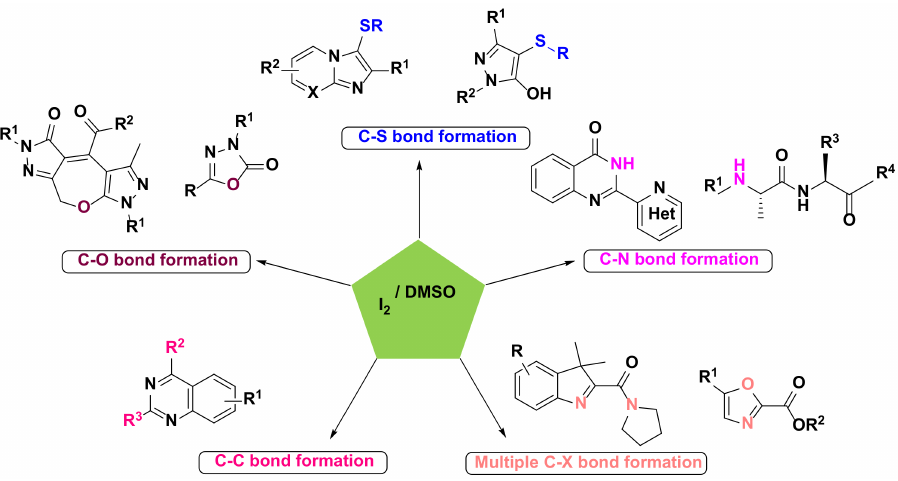
Figure 2. Formation of different types of C–X bonds catalyzed by I 2